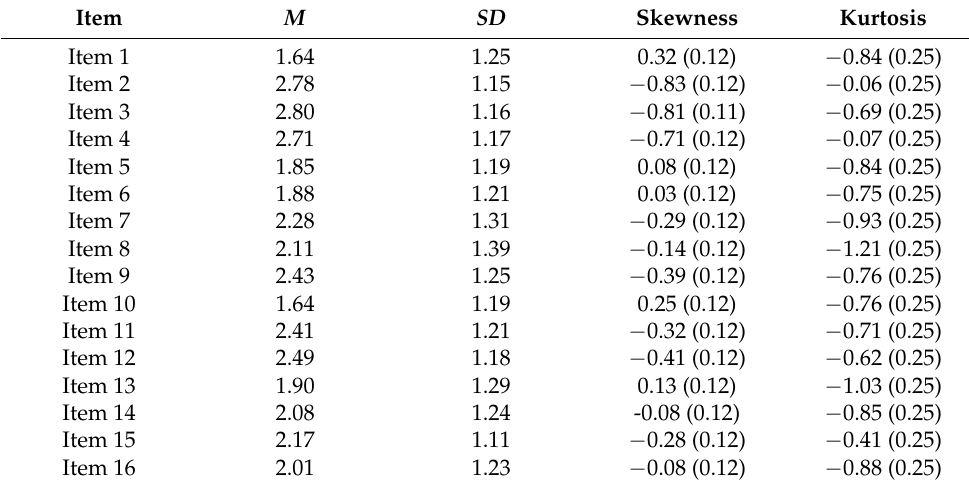
Table 2. Temperance scale items’ descriptive